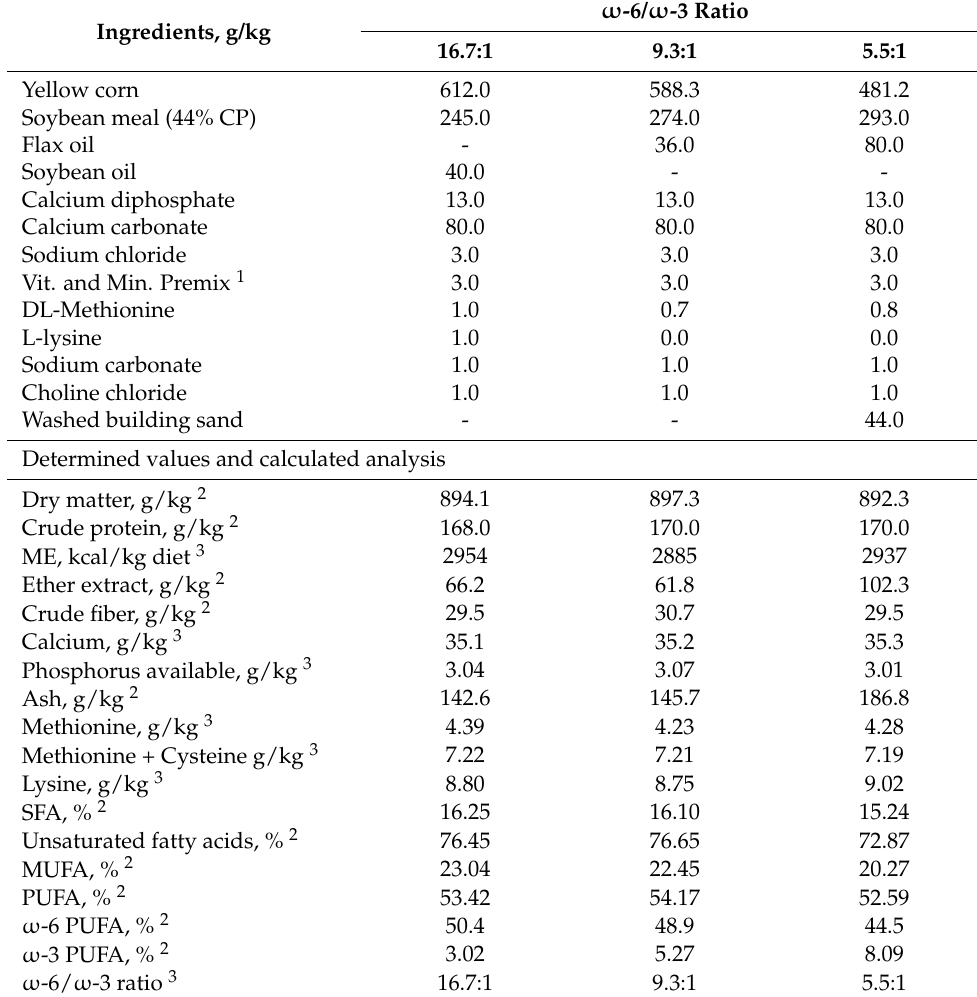
Table 1. Constituents and chemical profile of the experimental